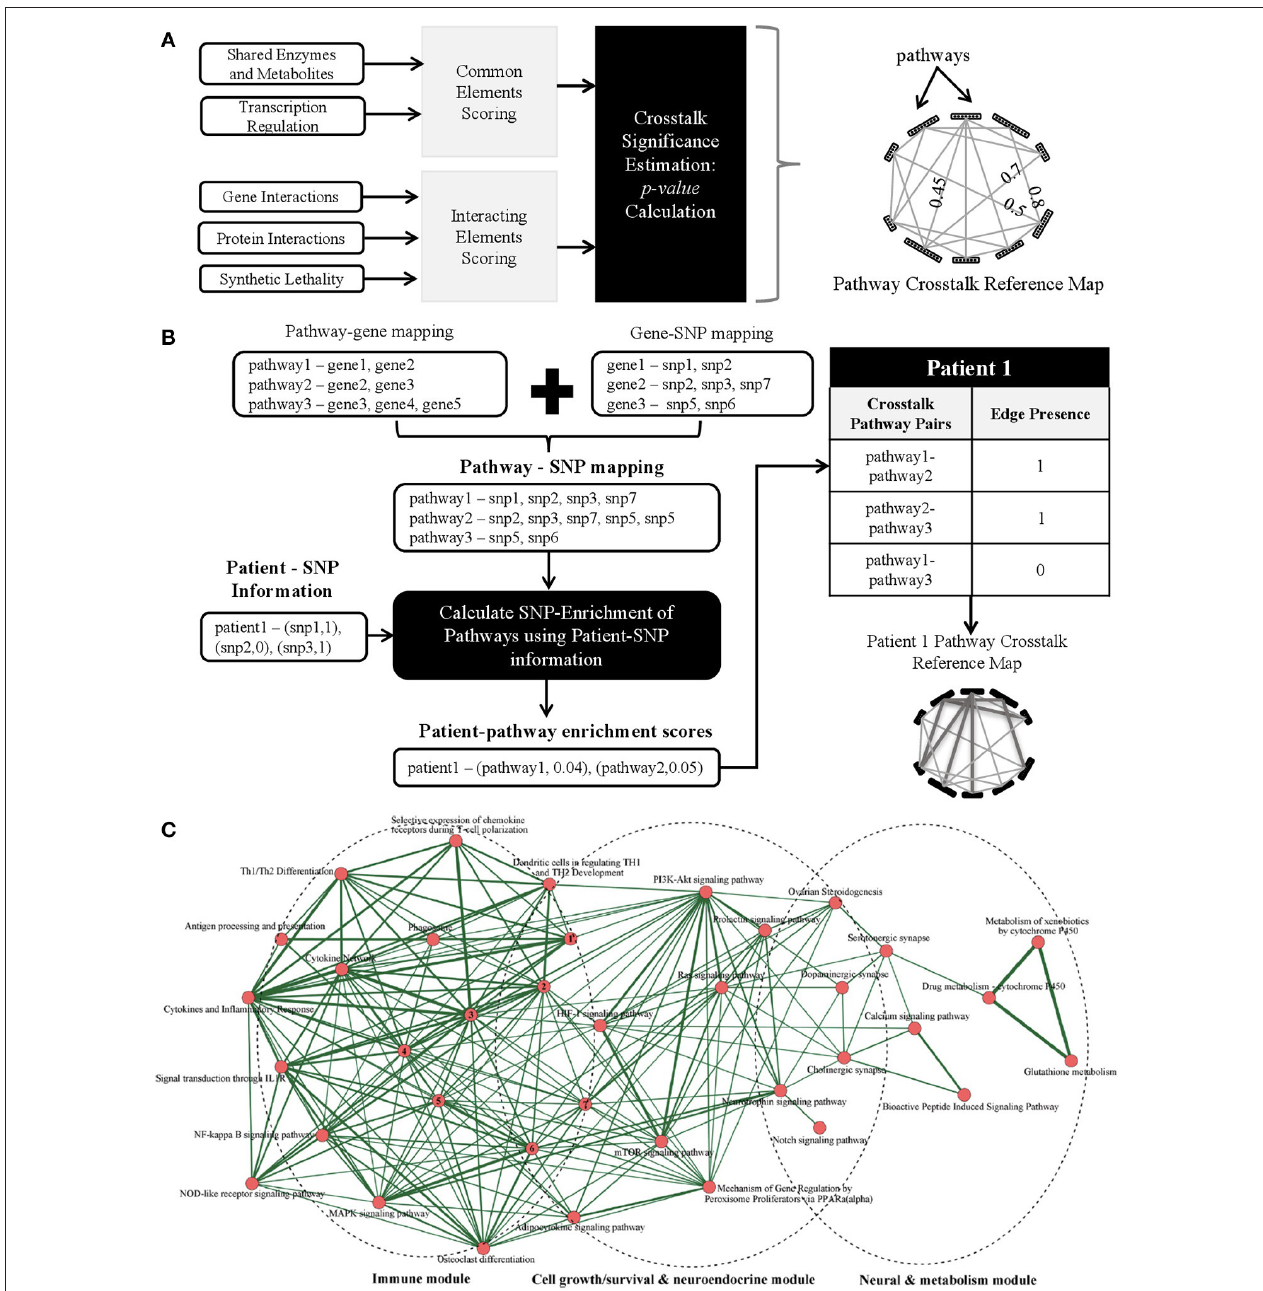
FIGURE 1 | (A) Proposed methods to identify potential pathway crosstalks. The methodology has three steps: (1) quantify crosstalk likelihood using multiple individual evidences to score each pathway pair, (2) obtain a combined score from a variety of evidence for possible crosstalks, and (3) build the generic crosstalk reference map. (B) Schematic methods to identify enriched patient-specific pathways and pathway crosstalks using SNP data as an example with three steps: (1) map SNPs to genes and, in turn, to pathways using SNP and gene location information, (2) choose a genetic model and calculate a patient-specific SNP enrichment score for each pathway using the patient’s allele information, and (3) overlaying the patient-specific pathway enrichment scores onto the reference crosstalk map to build patient-specific pathway crosstalk maps. (C) Crosstalk network amid Alzgset-overrepresented pathways. Vertices, biological pathways; lines, crosstalks among pathways. Width of one line (edge) shows direct proportion with the crosstalk level of a given pathway pair. Nodes tagged with numbers represent the following corresponding pathways: 1, intestinal immune network for IgA production; 2, toll-like receptor signaling pathway; 3, cytokine–cytokine receptor interaction; 4, hematopoietic cell lineage; 5, TNF signaling pathway; 6, apoptosis; 7, Fc ε RI signaling pathway. Panel C is reproduced with permission from Hu et al. (2017) courtesy of Ju Wang Ph.D., Tianjin Medical University.